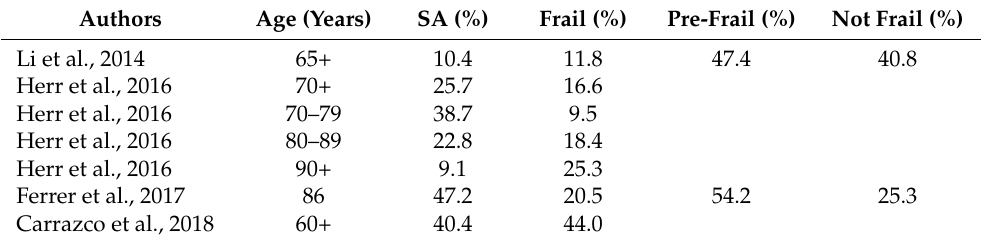
Table 3. Comparison of reported prevalence of frailty and successful aging by